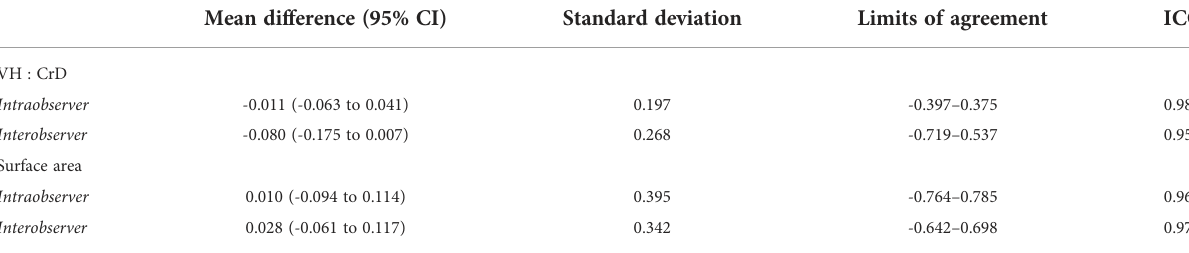
TABLE 3 Bland – Altman statistics for micro-CT with absolute values and intraclass correlation coef fi cients (ICC) for analyzing repeatability and agreement for mucosal morphometry and surface